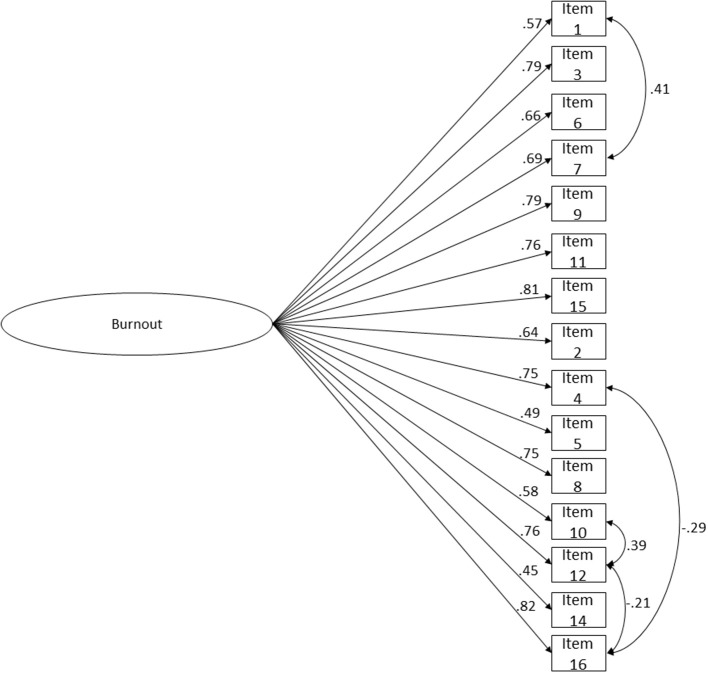
OLBI's unidimensional reduced version (15 items) structure fit. A combined sample of Portuguese (n = 268) and Brazilian (n = 318) workers. Residuals' correlations and factor loadings for each item are shown. χ(86)2 = 737.139; p < 0.001; n = 586; CFI = 0.979; CFIscaled = 0.913; NFI = 0.977; TLI = 0.975; SRMR = 0.077; RMSEA = 0.114; P(rmsea ≤ 0.05) < 0.001; 90% CI ]0.106; 0.121[.